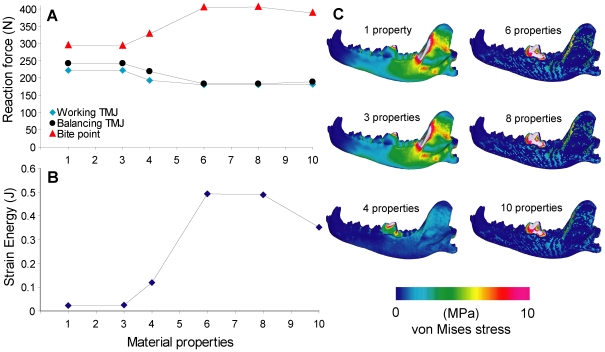
Sensitivity test on number of material properties.
A. Number of properties plotted against reaction force, connected by lines to show trend. B. Number of properties plotted against strain energy. C. von Mises stress distribution in the working-side dentary in test models.